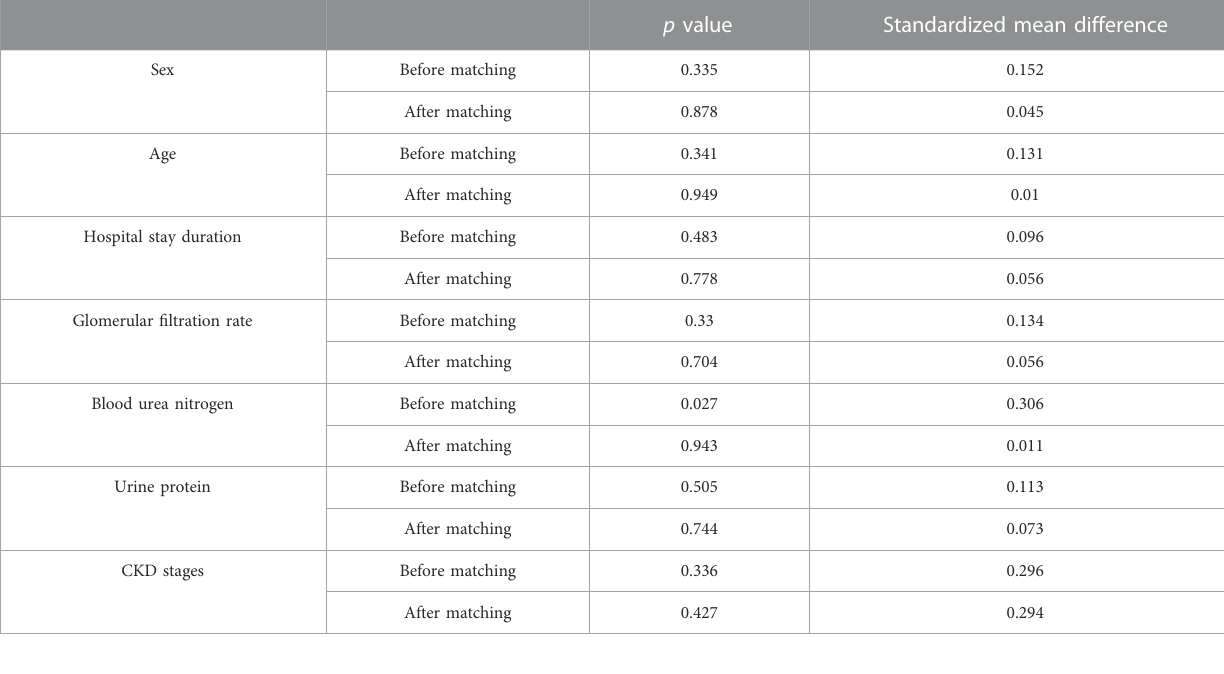
TABLE 1 Results before and after propensity score matching of HN cases.